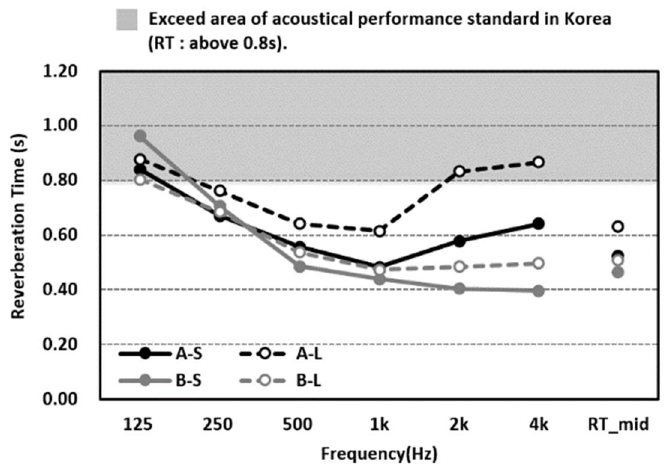
Figure 1. Measurement result of RT60 in four classrooms for the elderly (unoccupied).